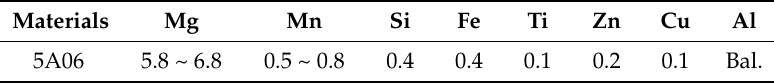
Table 1. Chemical composition of 5A06 aluminum alloy